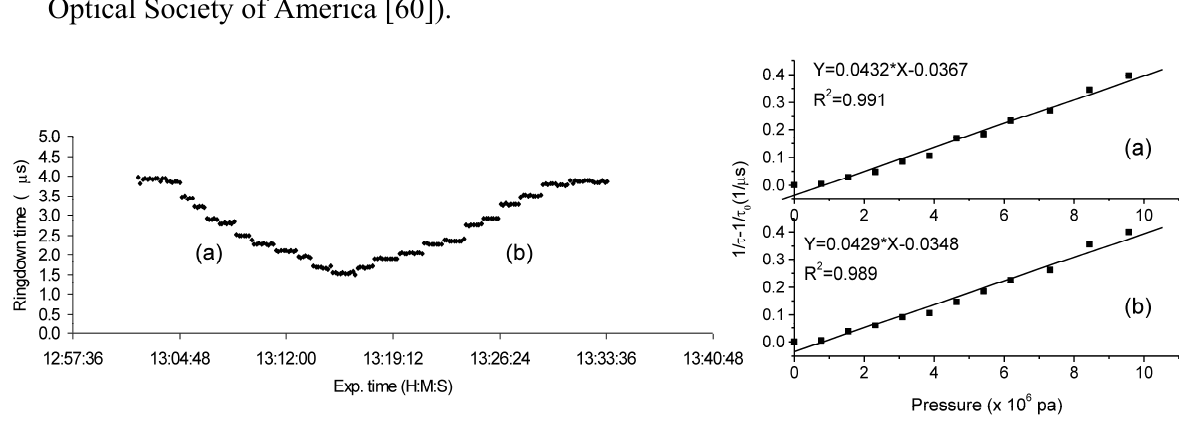
Figure 4. FLRD pressure sensor’s response. (Left) gradually load (a) and unload pressures; (Right) good linearity of the sensor’s response to pressures (Reproduction permission from Optical Society of America [60]).